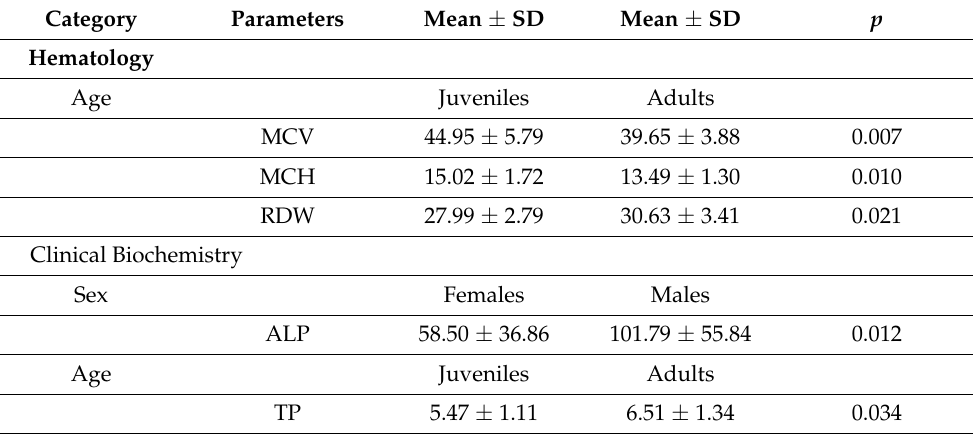
Table 3. Influence of sex and age on hematological and biochemical parameters in the species Erinaceus europaeus